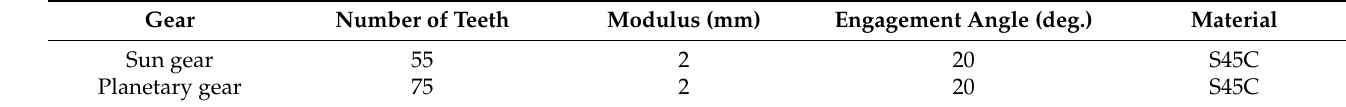
Figure 6. Test Bench. Table 2. Parameters of gear.